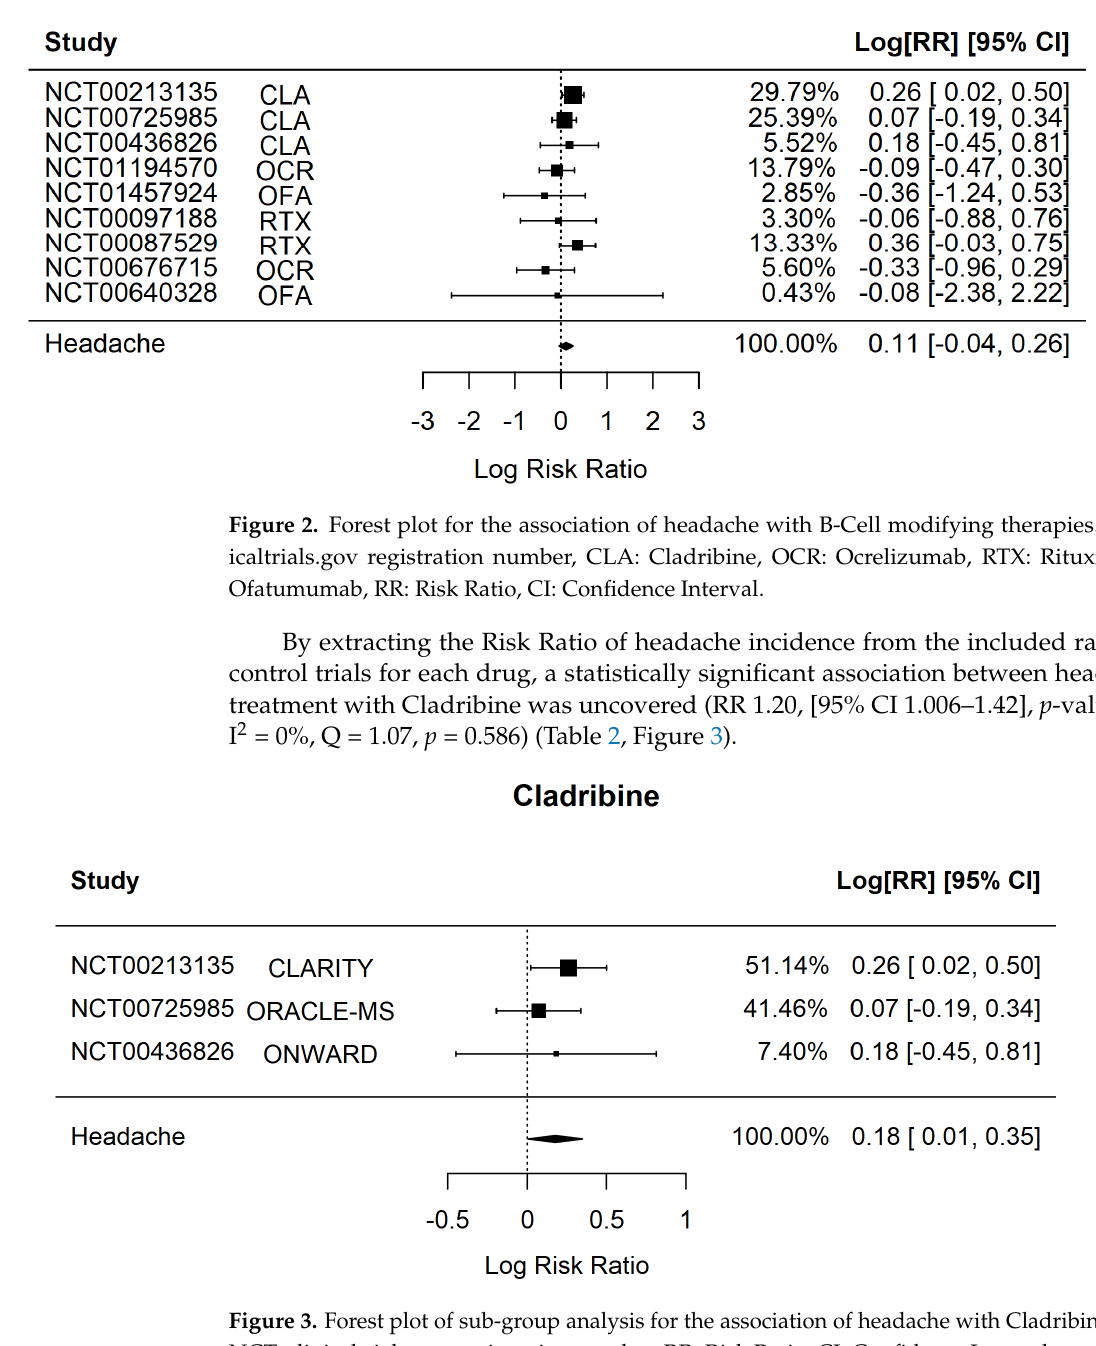
#: Number, RR: Risk Ratio for the incidence of headache, CI: Confidence Interval, I 2 Study Heterogeneity. The presence of headache was not associated, in general, with B-cell depleting therapy